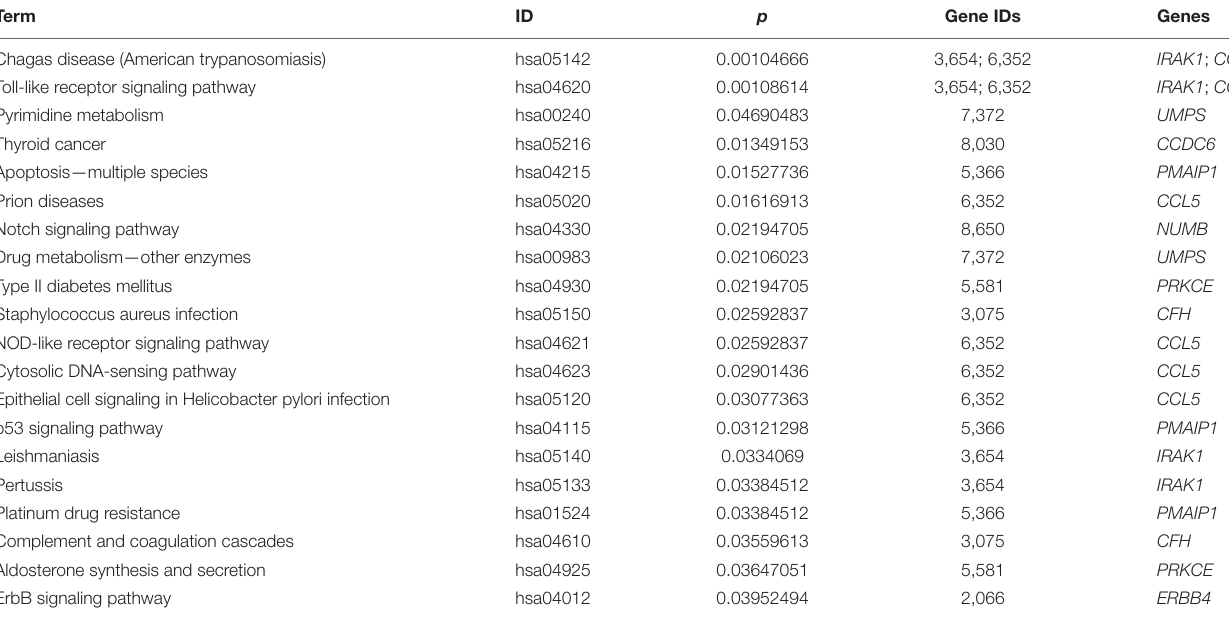
FIGURE 6 | KEGG pathway analysis for the target genes of miR-146a-5p with the top 20 enrichment scores. TABLE 3 | The top 20 most significant enriched KEGG pathway terms and the target genes of